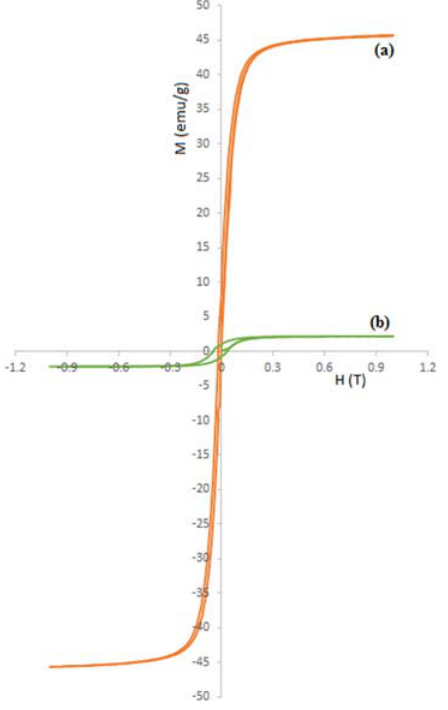
Figure 3: Fe 3 O 4 hysteresis curves without ( a ) and with the addition of silica – CTA ( b ) using